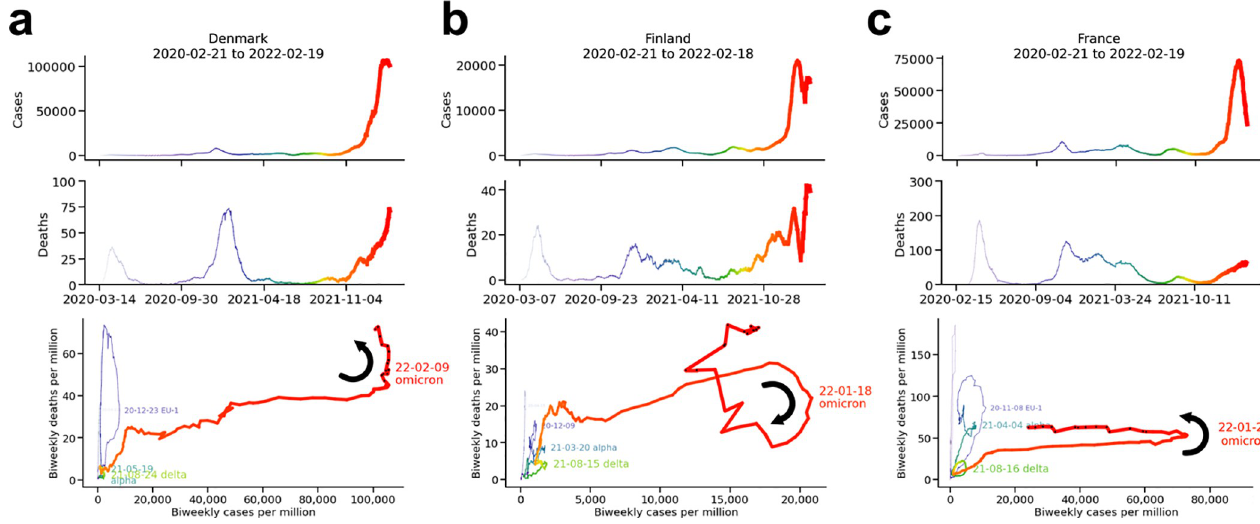
Fig 9. Time series vs. bivariate plots. (a) Denmark, (b) Finland, and (c) France.